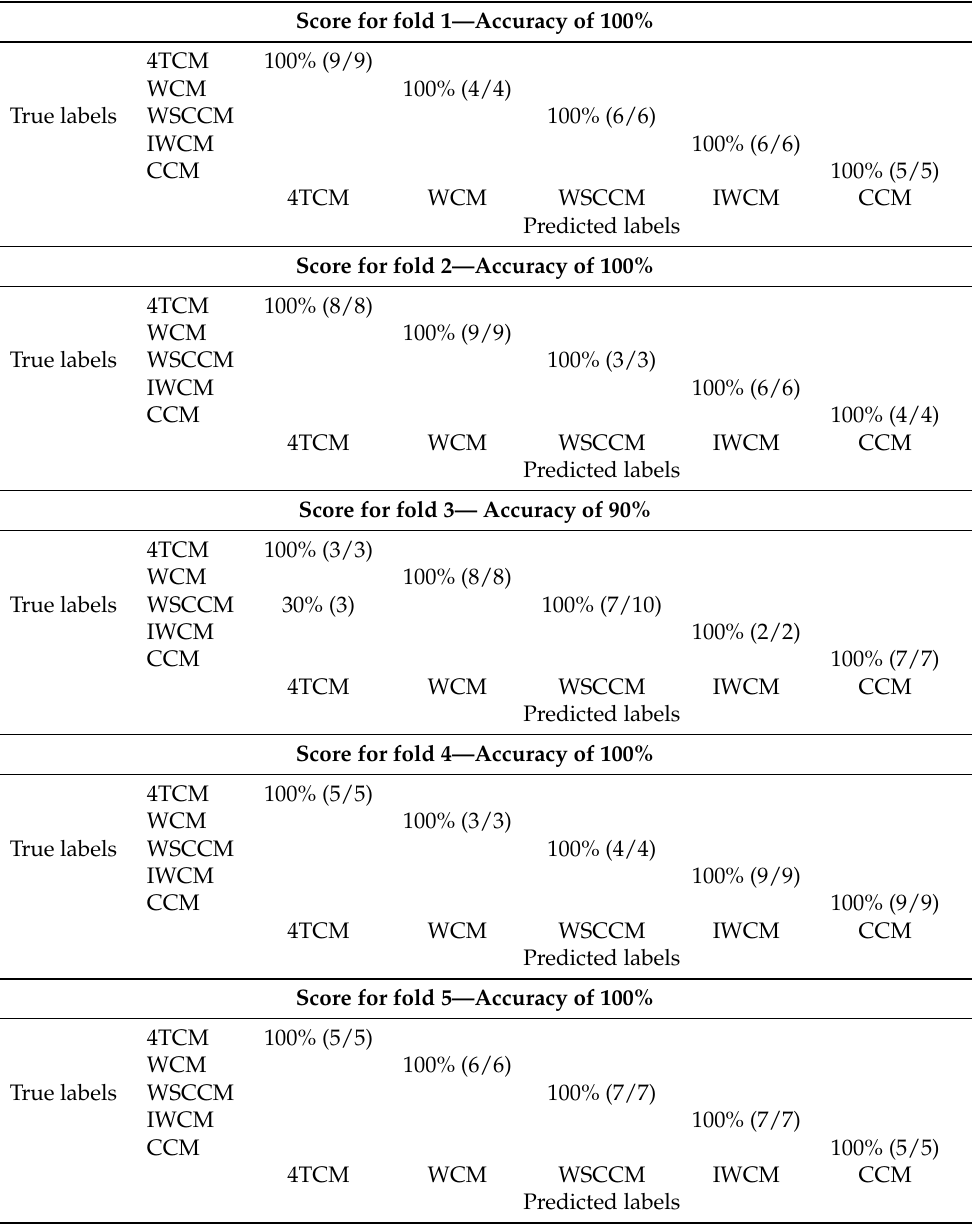
Table 4. K-Fold (5 folds case): 1/5 of the dataset is used for testing and the rest is used for training. A confusion matrix is drawn for each one of the five folds. They show 100% accuracy for fold 4, and 90% accuracy for fold